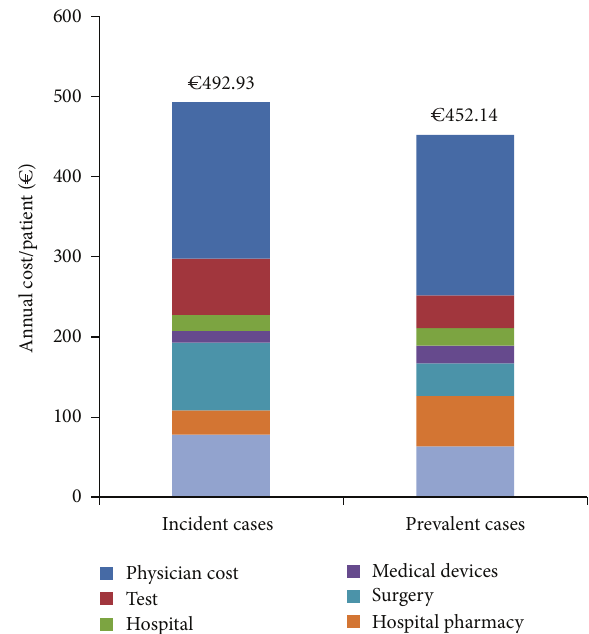
Figure 2: Inpatient and outpatient costs by